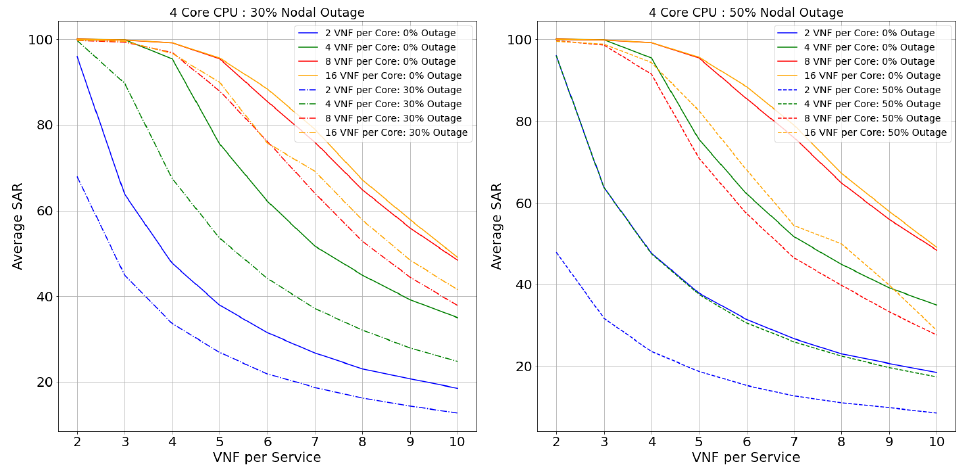
Figure 18. SAR: BtEurope topology with nodal outage—4 core